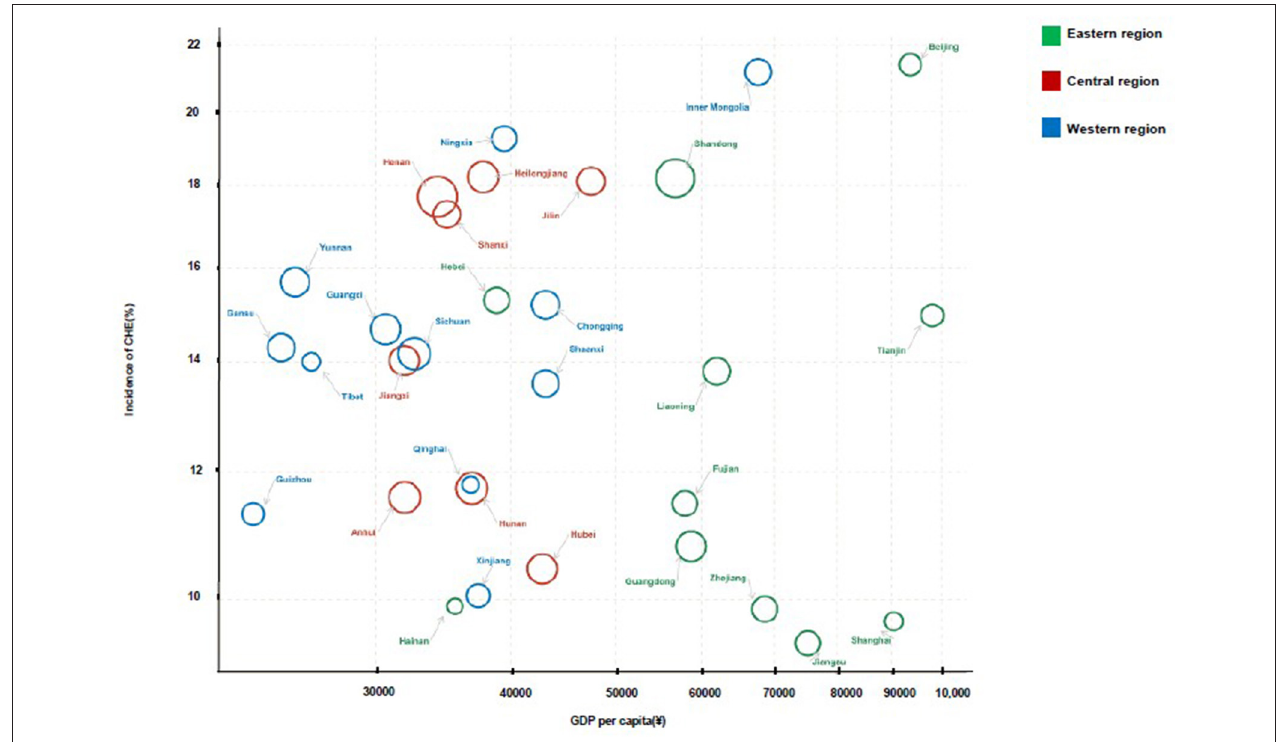
FIGURE 2 | The incidence of CHE across 31 provinces in